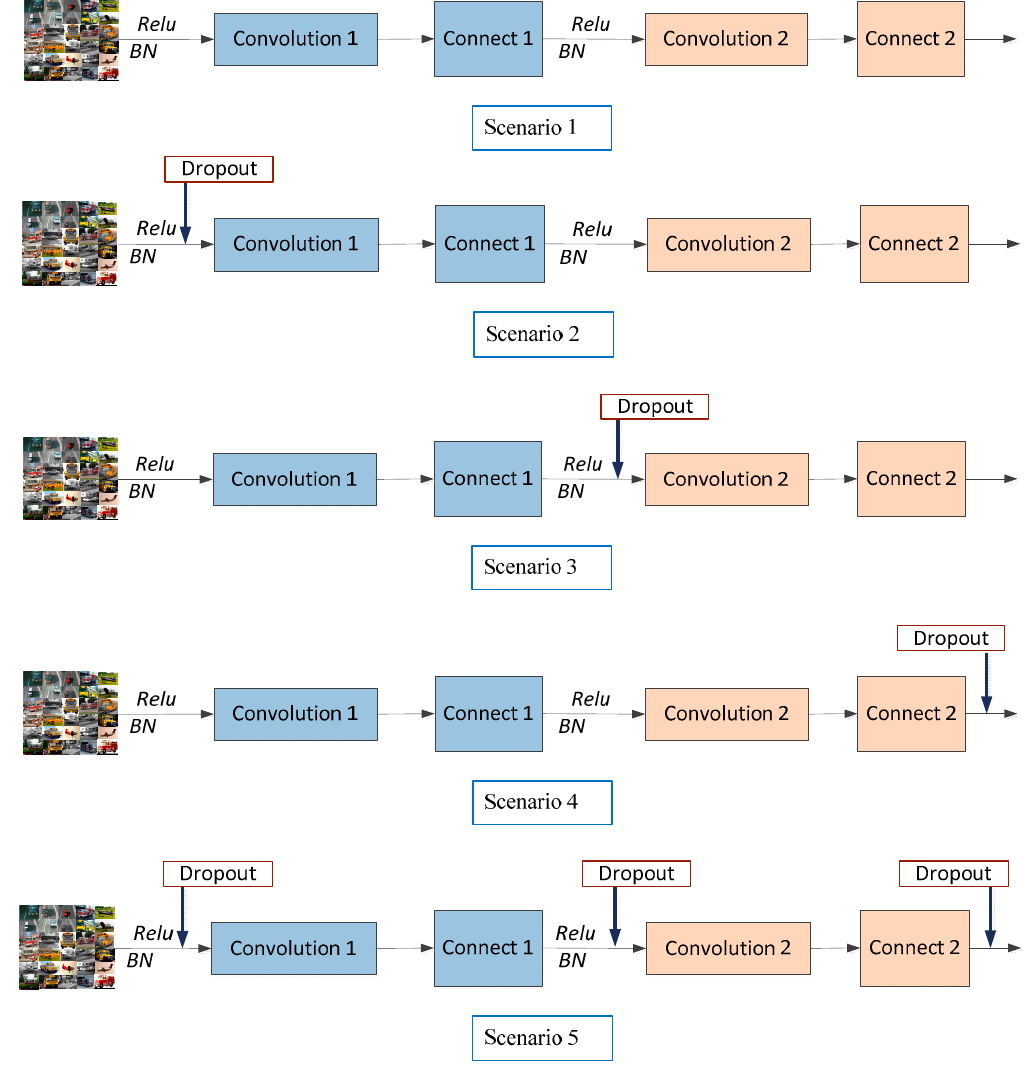
Figure 7. The module structure of different dropout locations.